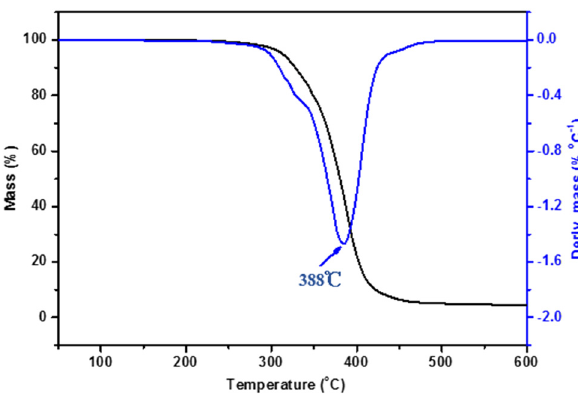
Figure 1: TG - DTG curve of polyacrylate PSA at heating rate of 4 K · min − 1 .